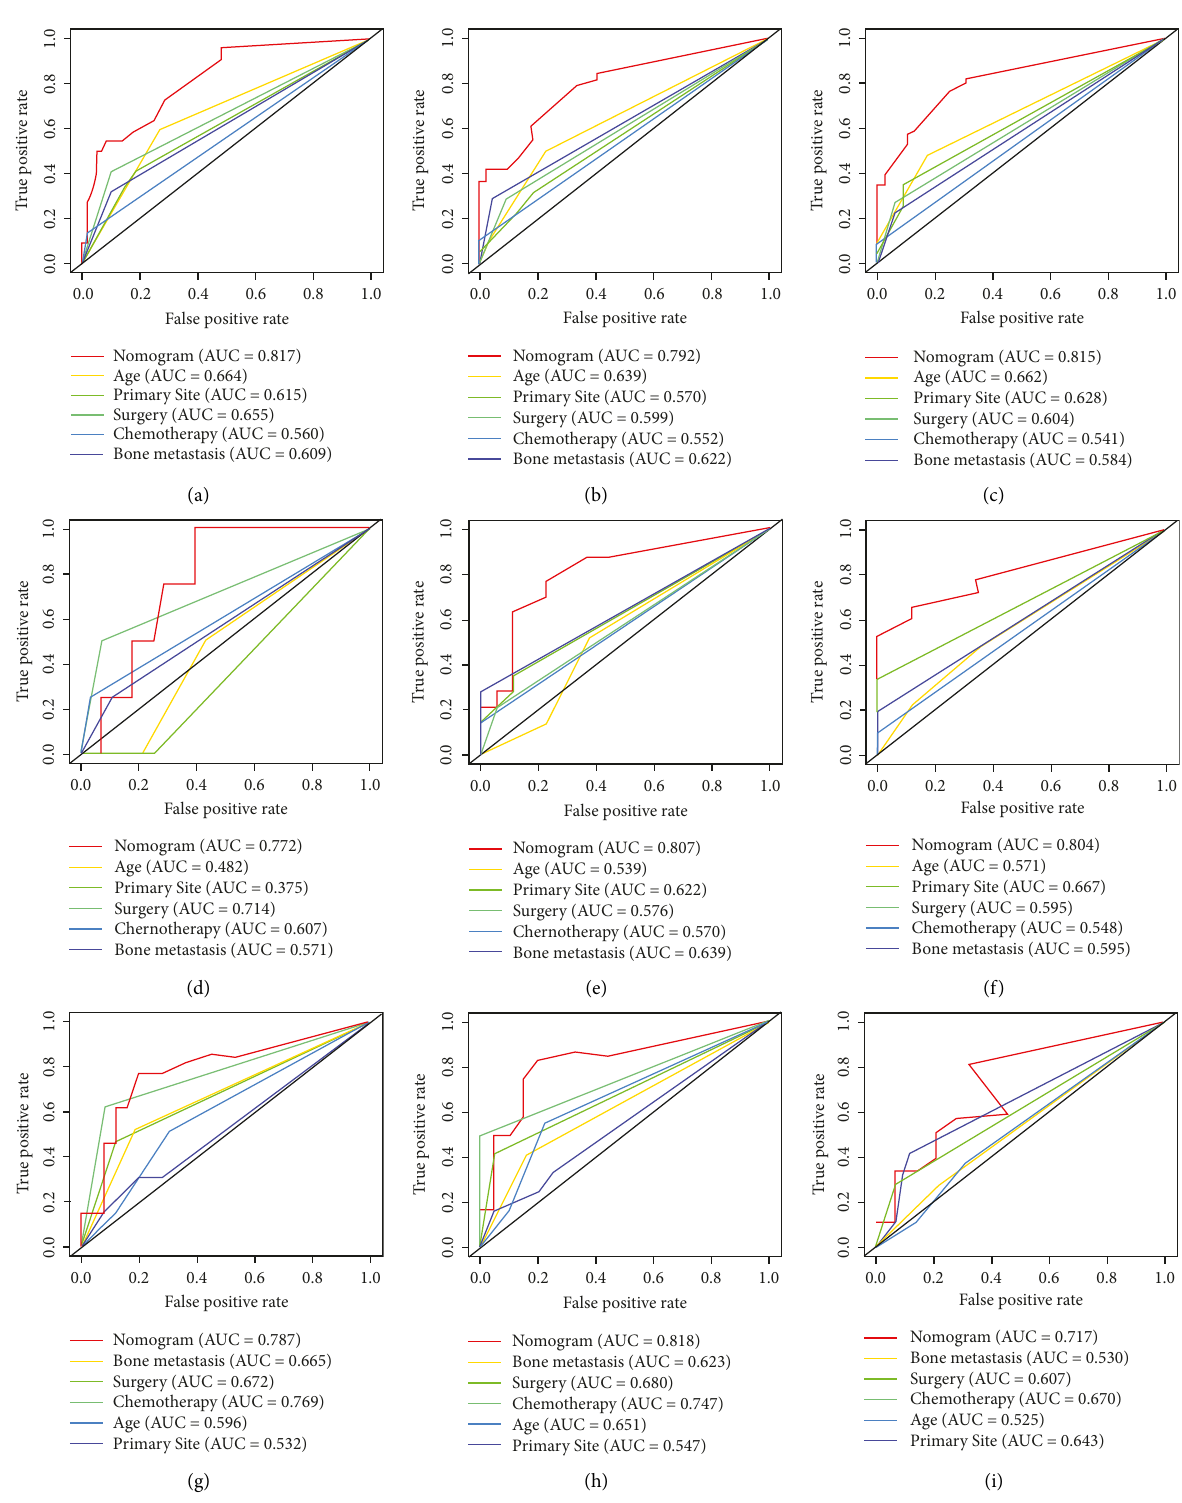
Figure 5: Comparison of the values of the area under the curve between the nomogram and single independent factors. 12-month, 24- month, and 36-month survival in the training set (a-c), internal validation set (d-f), and external validation set